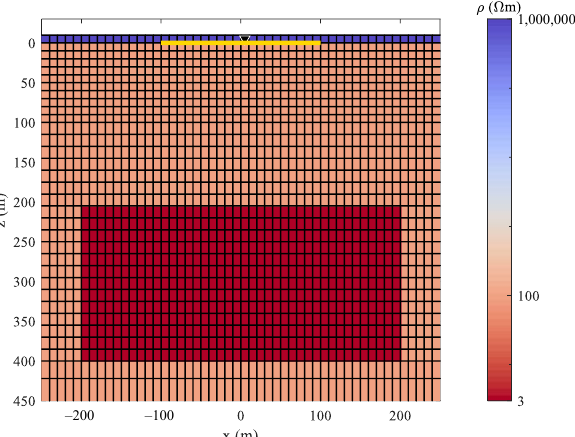
Figure 9. Example 3: 100 Ω m model, measurement configuration, and the grid discretization (central region). Yellow line and black cone denote loop source and observation site, respectively. The explicit scheme modeling grid is shown here in which only one air layer exists; the implicit scheme modeling grid has 15 air layers like the other examples. The other two models have the same grid discretization, only the resistivity of background and anomaly block change to ( 30 Ω m,1000 Ω m ) and ( 300 Ω m,10,000 Ω m )